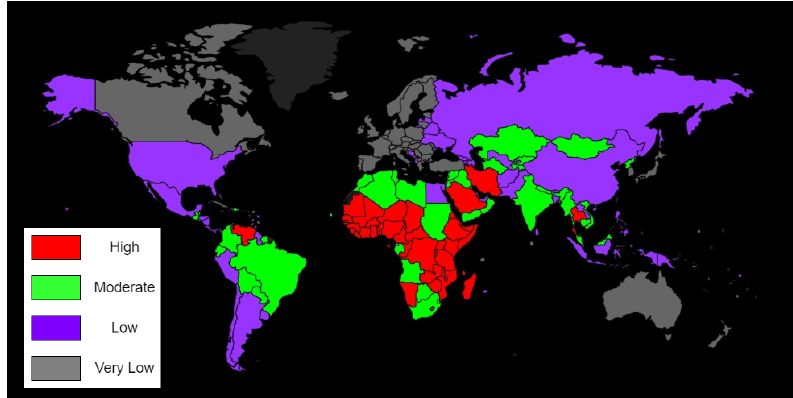
Figure 1. Worldwide road traffic death rate per 100,000 people